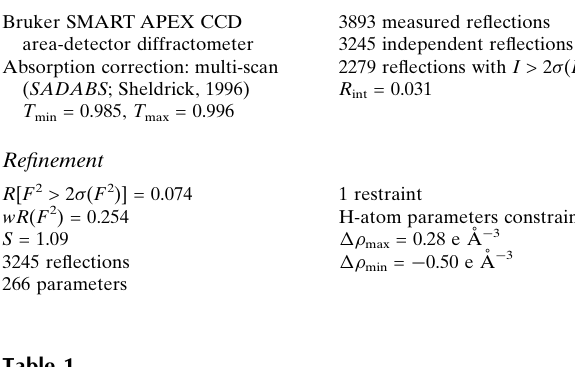
Hydrogen-bond geometry (A˚ , (cid:1)